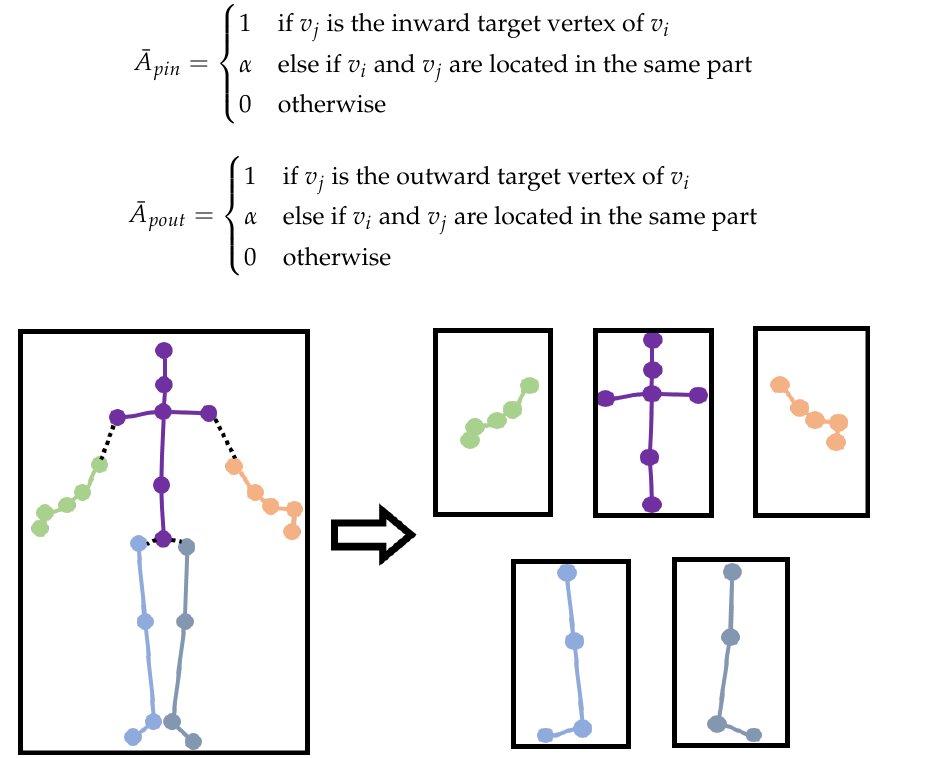
Figure 4. The division of subgraphs. The left figure shows the whole skeleton graph, and the right figure shows five subgraphs, which represent the left arm, torso, right arm, left leg, and right leg,